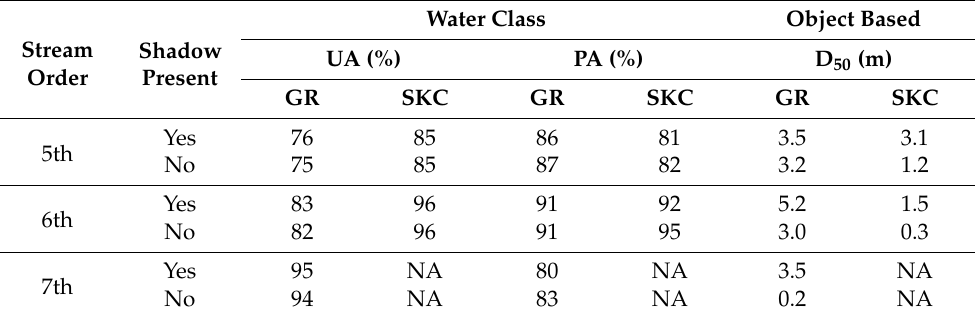
Table 2. Channel boundary delineation accuracy for Genesee River (GR) and Stockport and Kinder- hook Creek (SKC) grouped by stream order and presence of image shadow. Expanded object-based accuracy assessment results are provided in the Supplementary Materials (Figures S1 and S2).